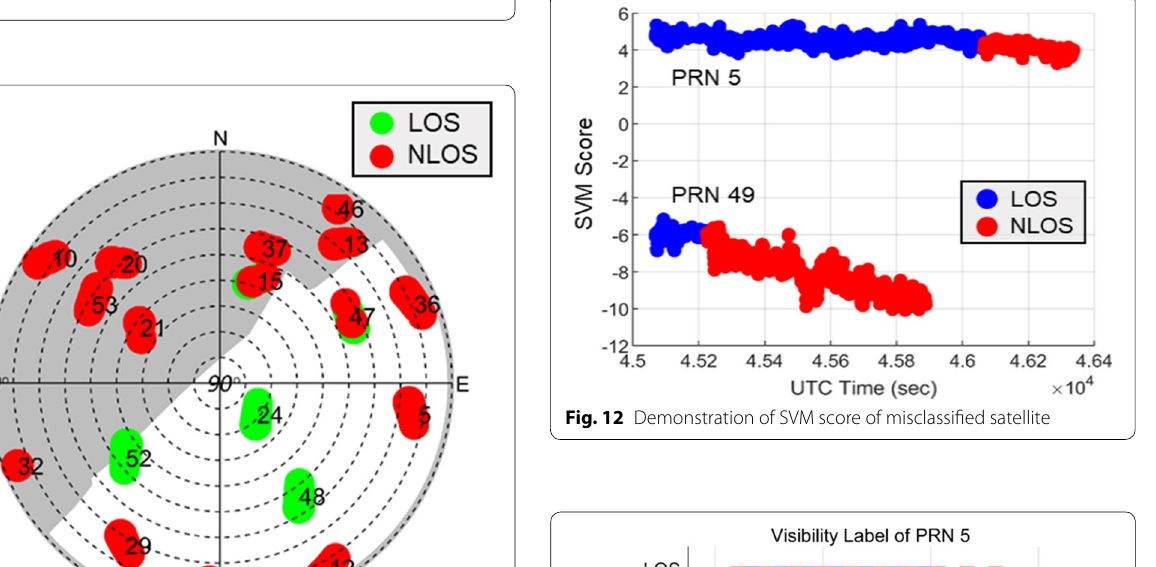
Fig. 9 Skyplot of P6 with the satellite visibilities labelled from ground truth